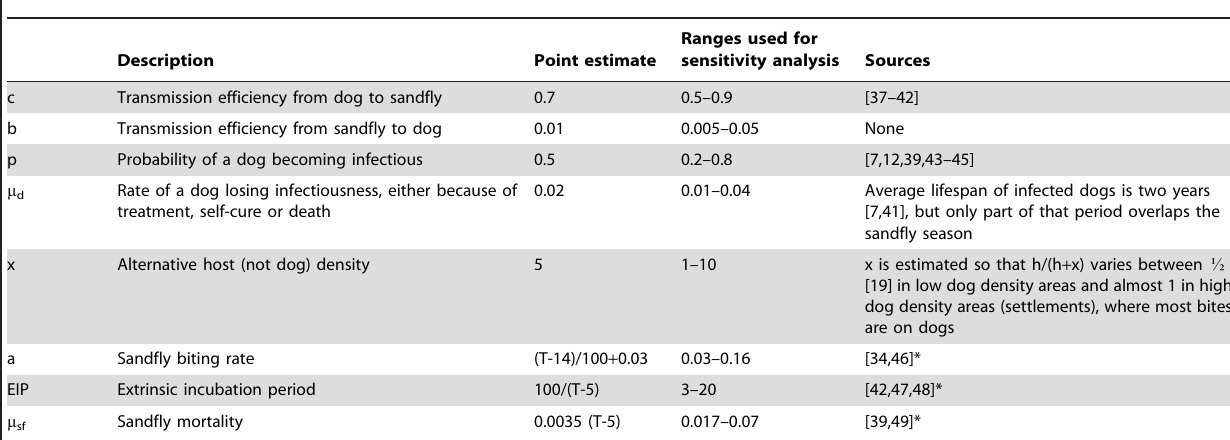
Table 1. Parameters: point estimates and